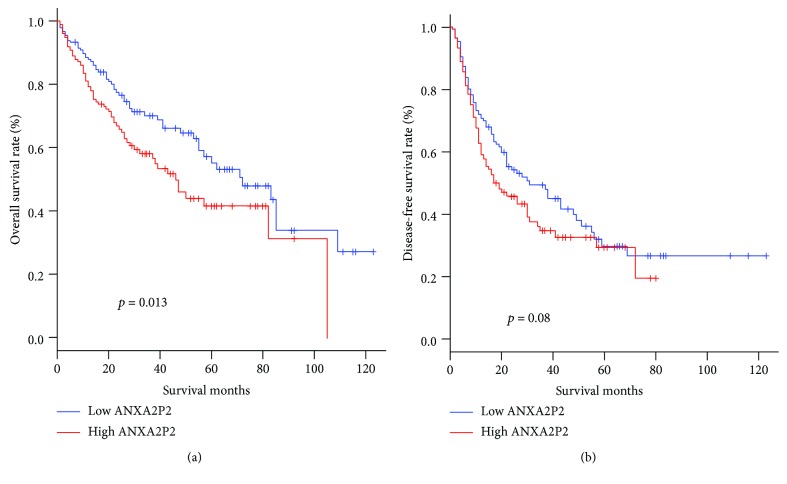
High expression levels of ANXA2P2 are associated with poor overall survival of hepatocellular carcinoma patients. Kaplan–Meier survival curve analysis with log-rank comparison was performed according to the ANXA2P2 expression level in TCGA dataset (364 cases, among them 182 cases with high and 182 with low expression levels). (a) The amplification of ANXA2P2 is associated with the OS of hepatocellular carcinoma (HCC) patients in TCGA dataset (p = 0.013). (b) ANXA2P2 expression level is not statistically associated with the DFS of HCC patients in TCGA dataset (p = 0.08).